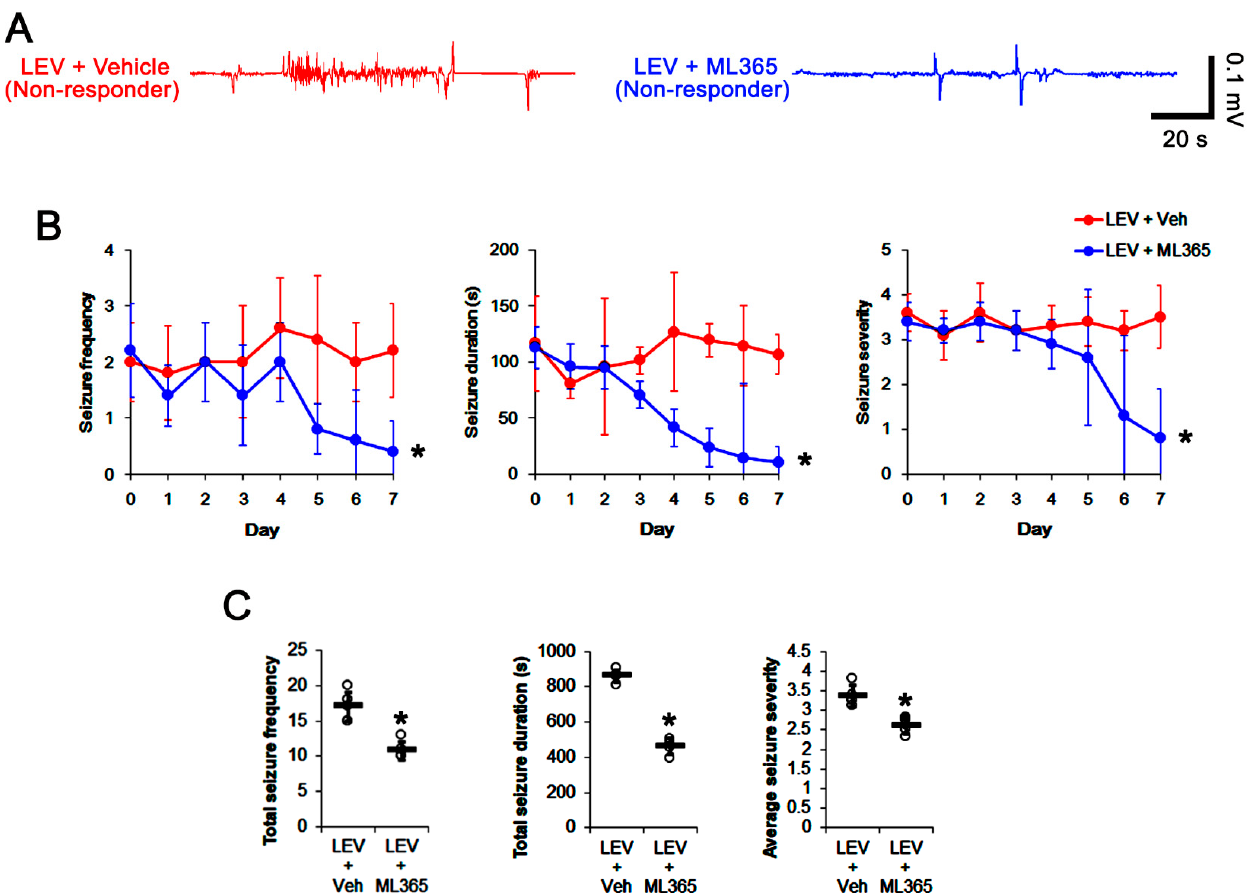
ML365 on the fraction of TASK-1 positive astrocytes in total astrocytes (*, p < 0.05 vs. control animals; Student’s t -test; error bars, SEM). ( D ) Representative images for Western blot of TASK-1 protein expression in the hippocampal tissues. ( E ) Quantification of TASK-1 levels based on Western blots (*, p < 0.05 vs. vehicle-treated animals; Student’s t -test).